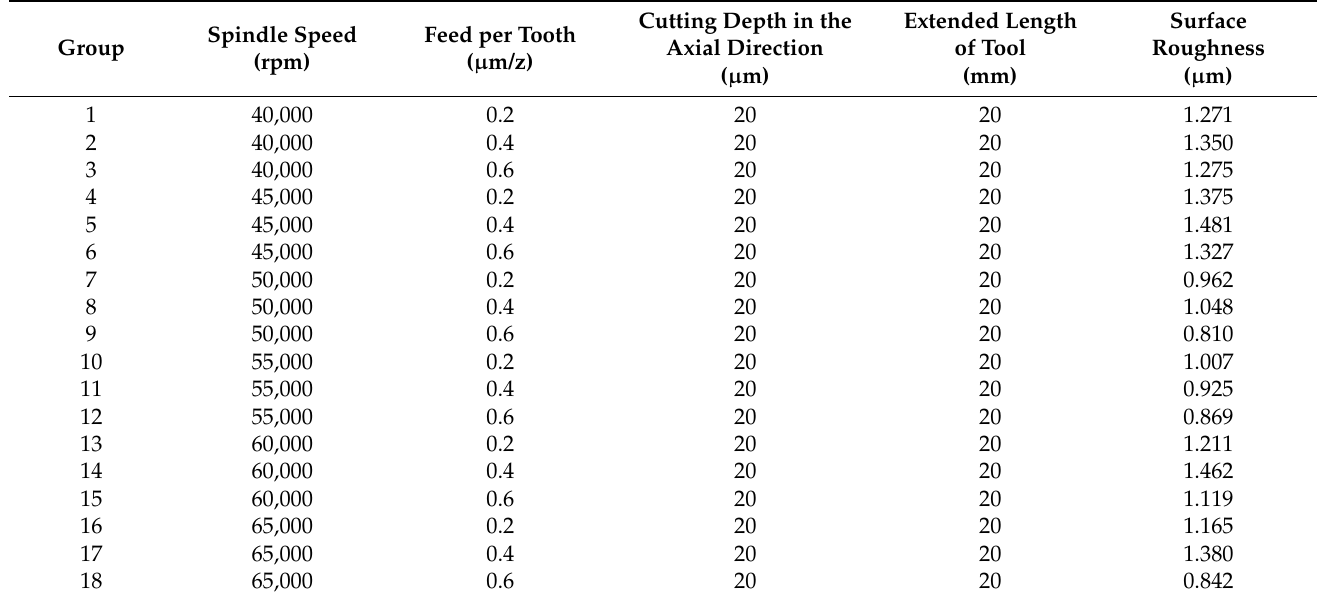
Table 3. Experimental results of micro-milling